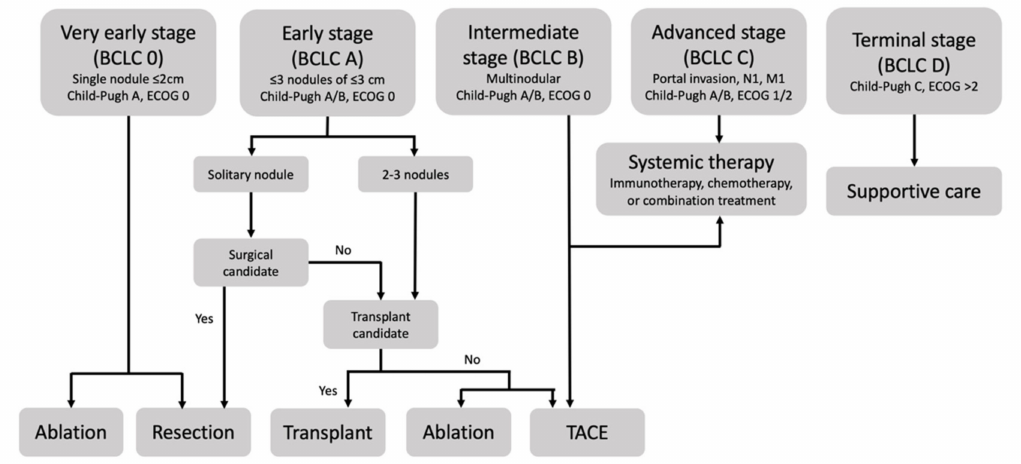
Figure 1. The Barcelona Clinic Liver Classification defines five stages of hepatocellular carcinoma based on assessment of disease distribution, liver function, and performance status and recommends therapy based on